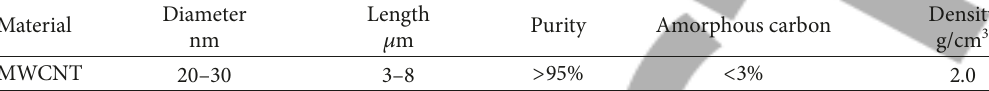
Figure 1: SEM image of Ball milled samples. Table 1: Specifications of